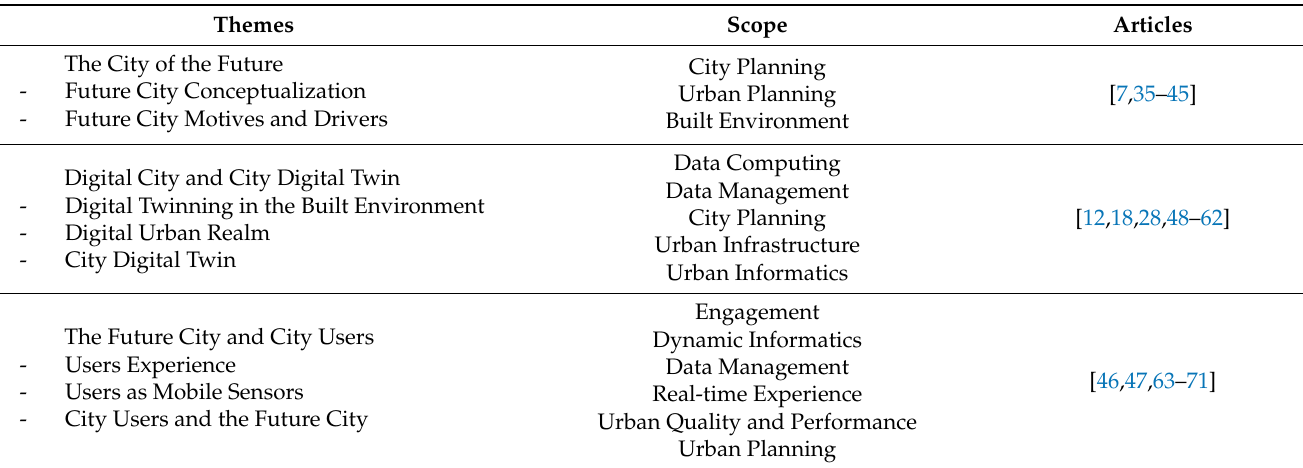
Table 4. Literature analysis